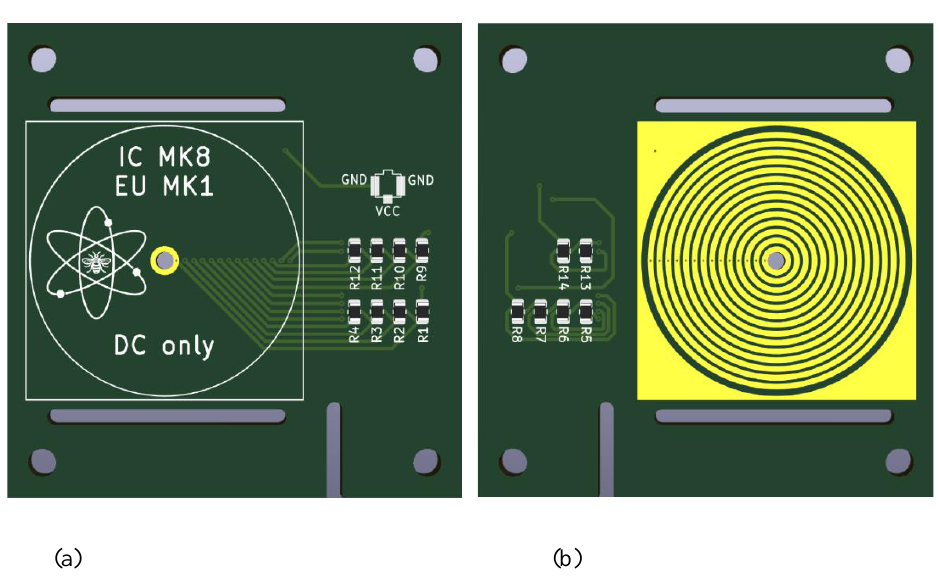
Fig. 5 . 3D rendering of the top (a) and bottom (b) panels of the ion carpet which extracts the ions that traversed through the ICP-MS quadruple.